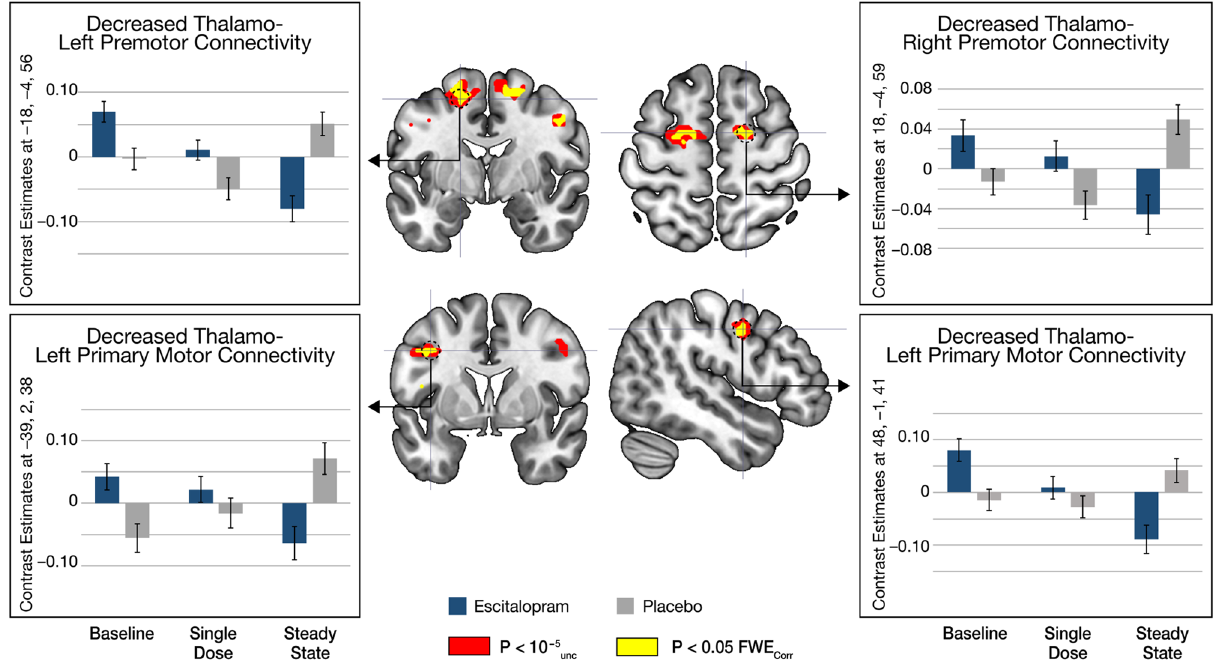
Figure 2. Contrast estimates from motor regions showing a gradual decreases in the thalamo-cortico PPI Learning contrast from baseline to steady state. Contrast estimates extracted from the escitalopram group motor regions at each time point show a gradual decrease in the PPI Learning contrast over the course of the administration week. Orthogonal brain slices show regions significant in a 2 × 2 flexible factorial analysis comparing groups from baseline to steady state. Results are shown at both a p < 10 –5 cluster corrected threshold (red) and p < 0.05 with FWE correction at the voxel level (yellow).